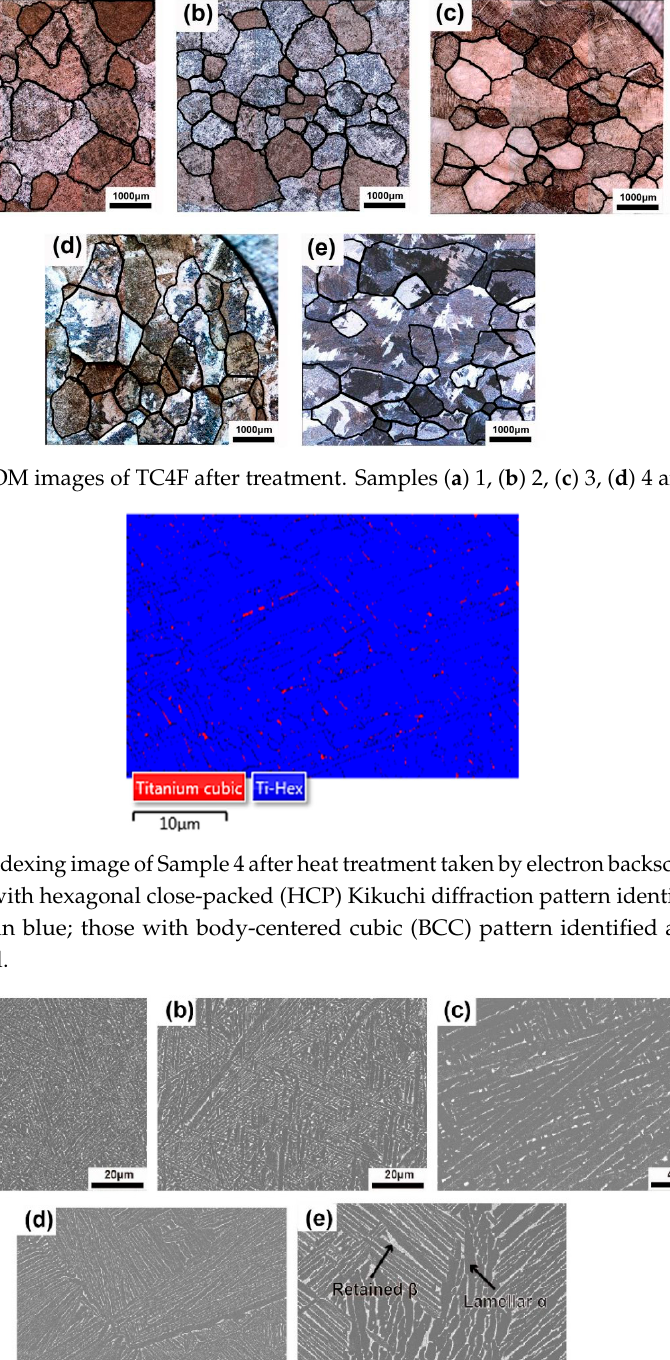
Figure 5. Distribution of microstructural features of TC4F Sample 1 after treatment. ( a ) Length of lamellar α , ( b ) width of lamellar α , ( c ) width of retained β , and ( d ) aspect-ratio distribution of lamellar α . Microstructural features followed Gaussian distribution. Most probable values of α length, width, aspect ratio, and retained β were ~4, ~0.85, ~5, and ~0.175 μ m, respectively.